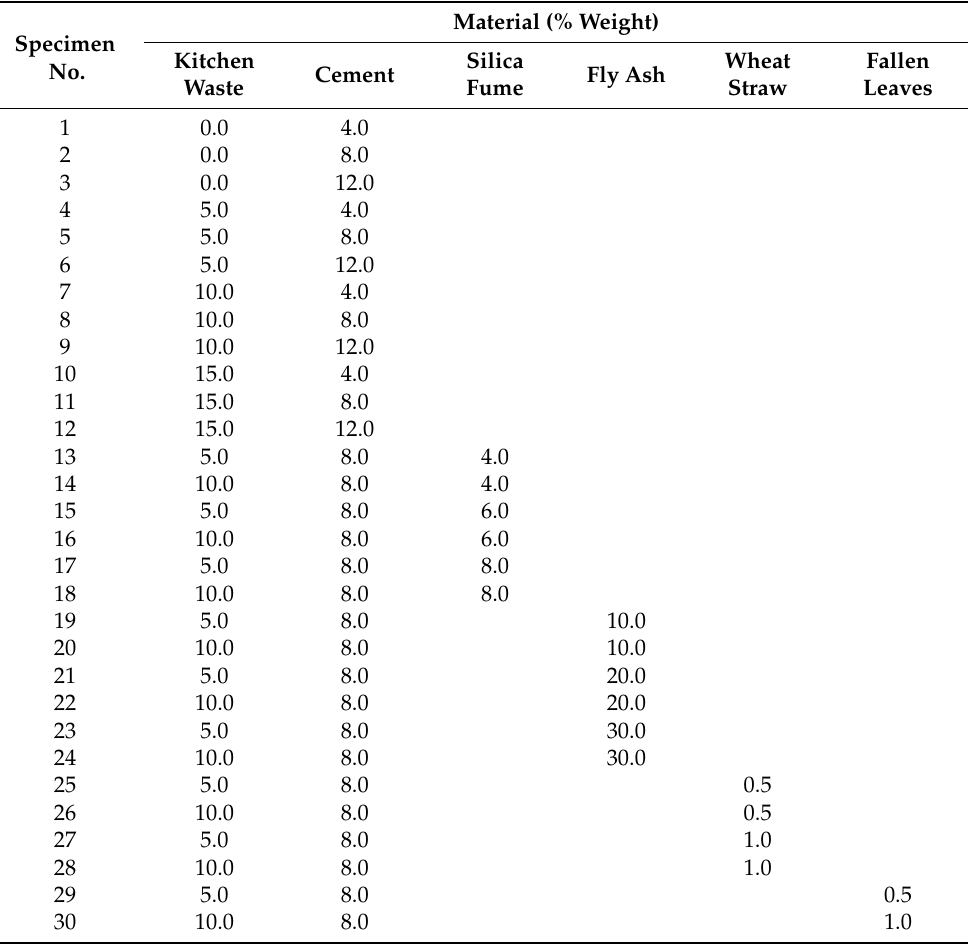
Table 2. Composition ratios of the MSW for